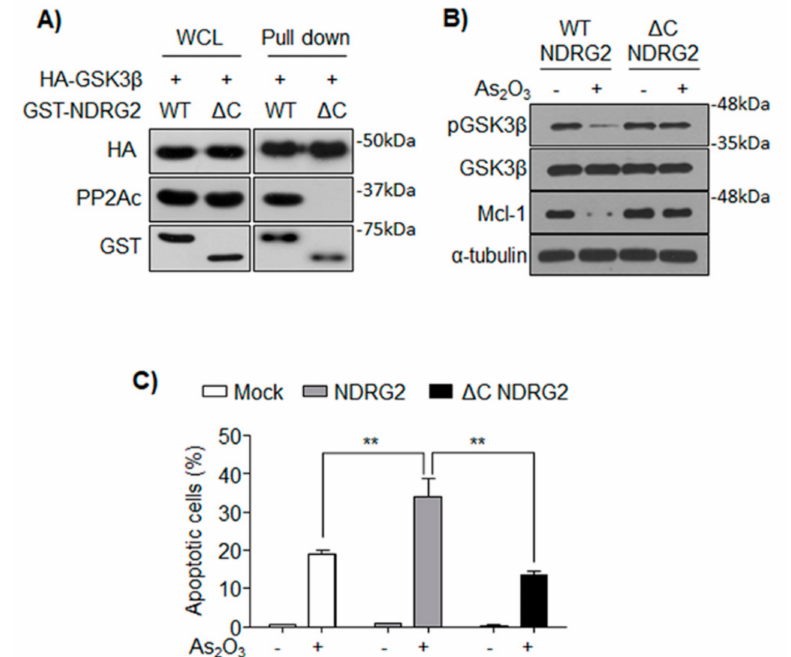
Figure 5. NDRG2 interacts with PP2Ac through its C-terminal, and NDRG2 ∆ C is incapable of sensitizing U937-NDRG2 to As 2 O 3 . ( A ) NDRG2 wild type (WT) or NDRG2 ∆ C was